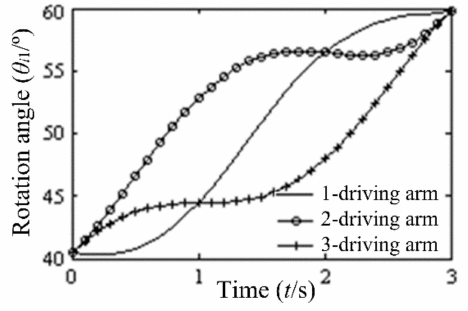
Figure 4. Change of the rotation angle θ i1 of three driving arms.